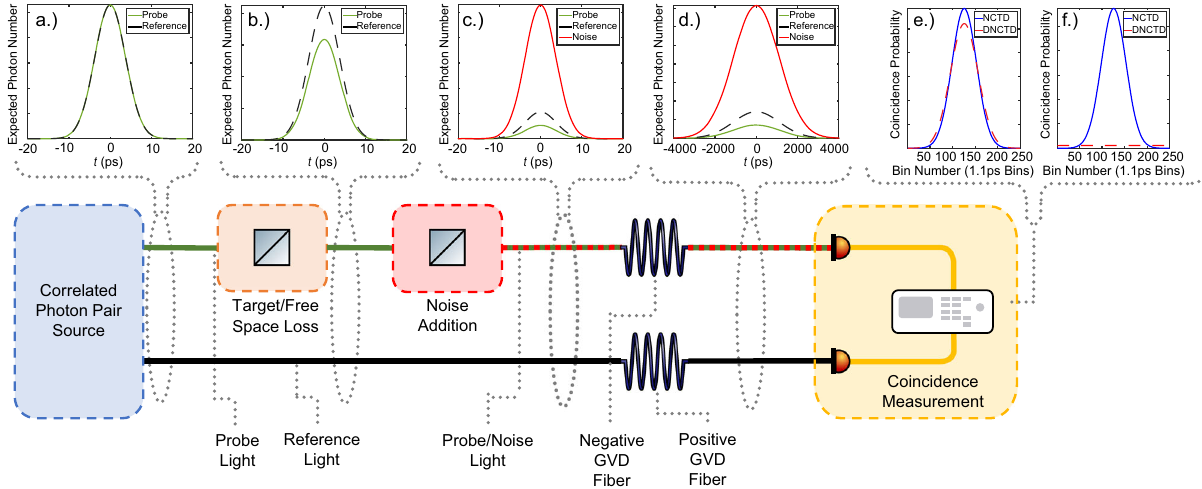
Fig. 1 | Logical diagram of the experimental setup with illustrative temporal distributions. a Temporal distribution of probe and reference photons directly afterspontaneousparametricdownconversion(SPDC). b Temporaldistributionof the probe and reference photons after free-space/target loss. c Temporal dis- tribution of the noise, probe, and reference photons after coupling of environ- mental noise. d Temporal distribution of the noise, probe, and reference photons after positive and negative group-velocity dispersion (GVD) fi bers. f Theoretical